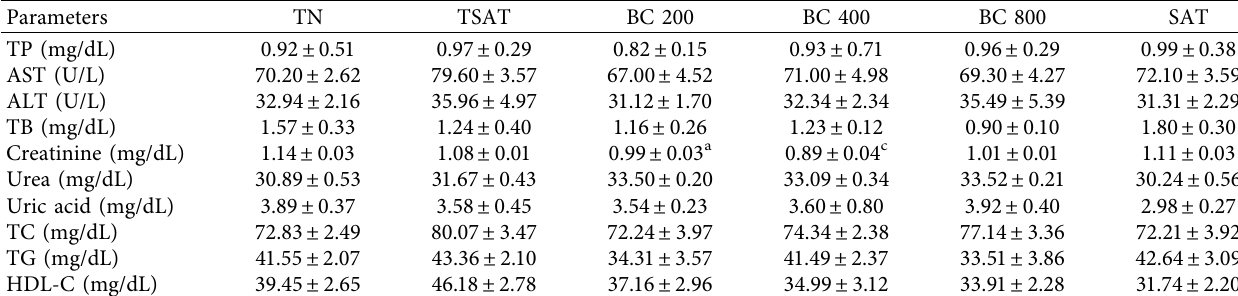
Table 5: Efects of the plant mixture aqueous extract on serum biochemical parameters in